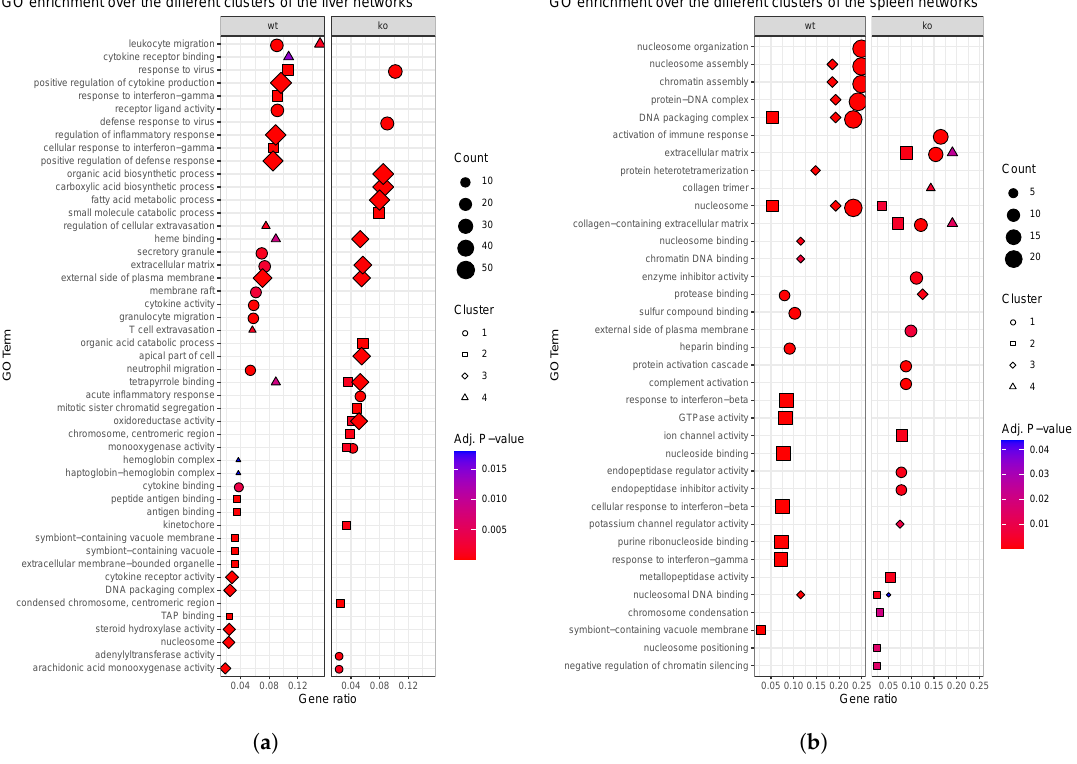
Figure 5. Enrichment analyses performed over the main clusters identified in wt and ko networks of ( a ) liver and ( b ) spleen networks. Gene ratio is defined by the number of genes used as input for the ernichment analyses associated with a particular GO term divided by the total number of input genes.